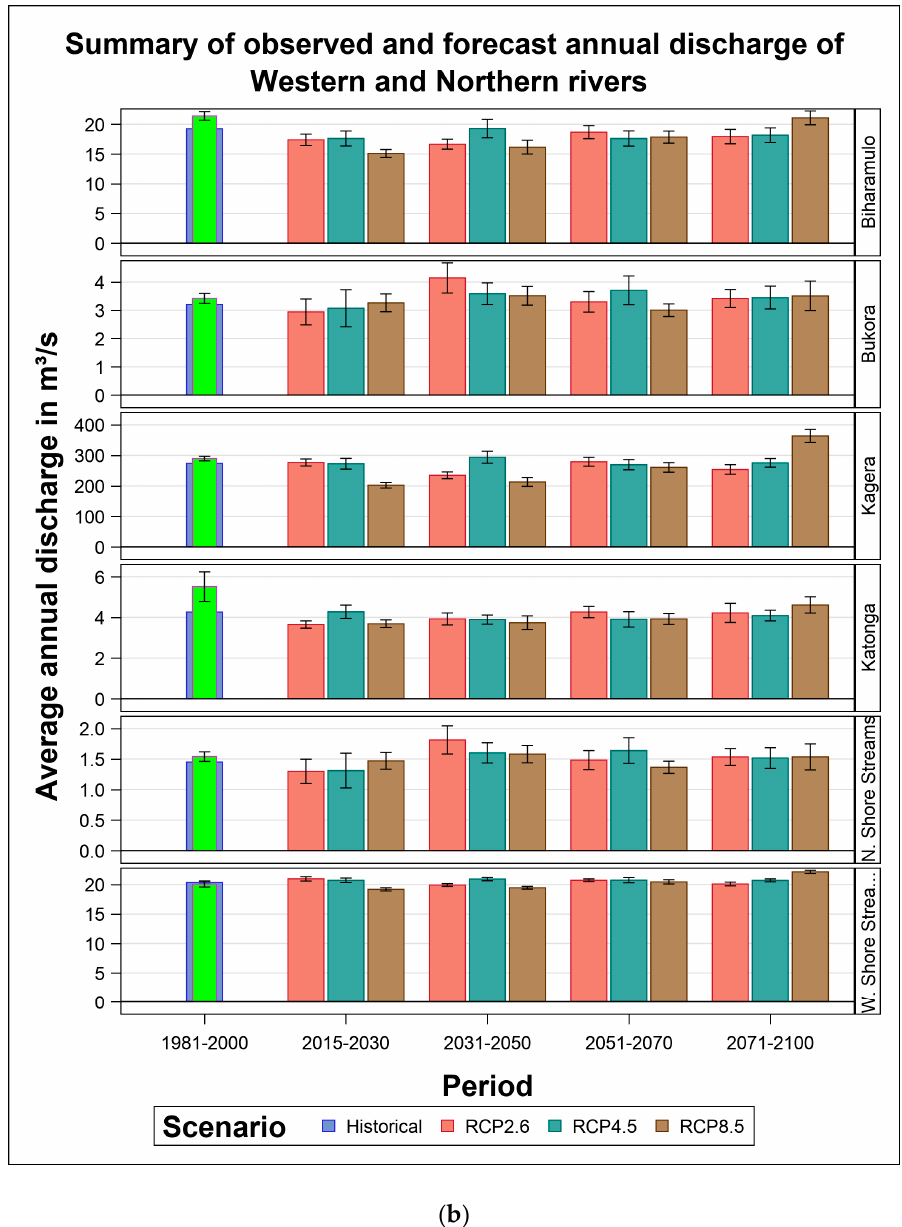
Figure 7. ( a ) Projecting average annual river discharge in relation to rainfall and ( b ) summary of the observed (historical) and projected average annual discharge for rivers flowing from the western and northern parts of the Lake Victoria Basin for the 2030s, 2050s, and 2070s under the RCP 2.6, 4.5, and 8.5 scenarios. The bright green bar is the average of the observed historic series whereas the wider medium slate blue bar is the value for the historic series predicted by the fitted model.